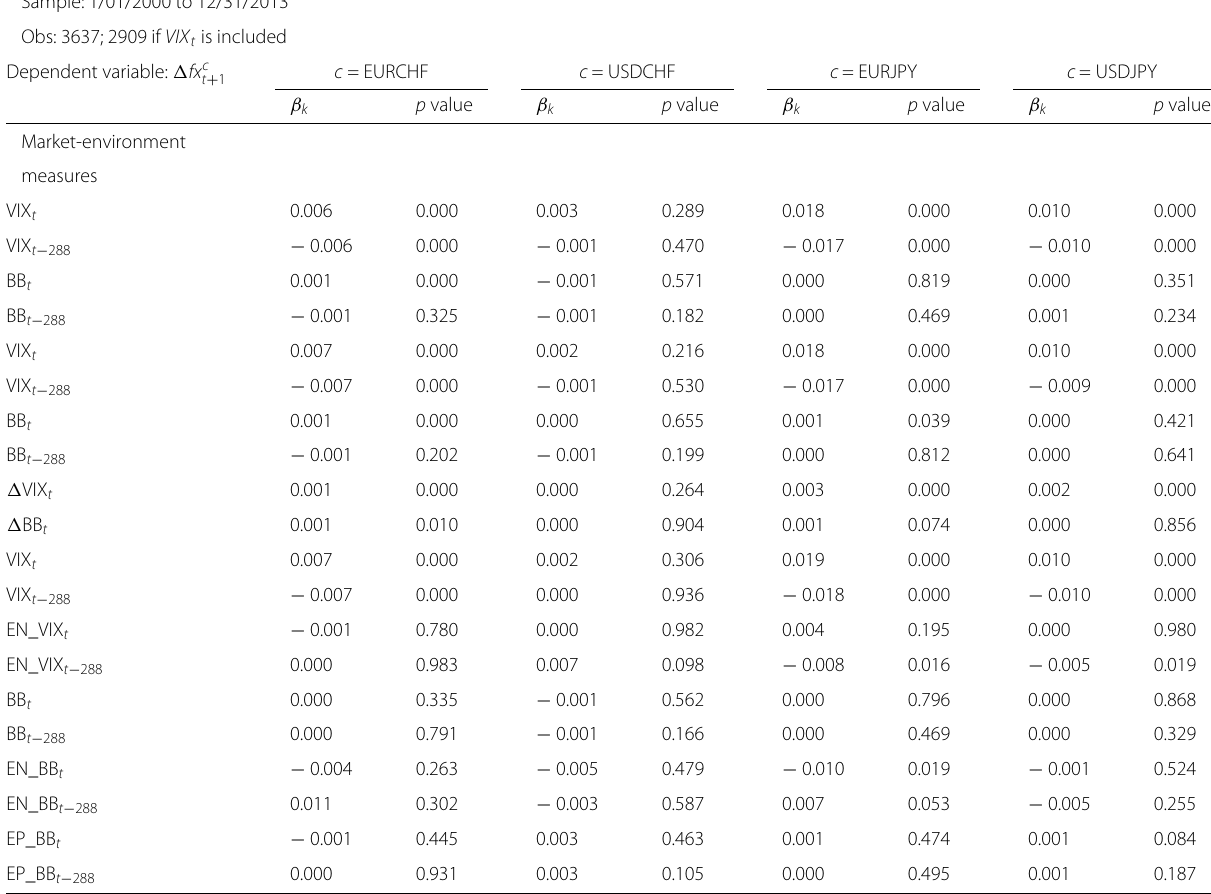
Table A2 Role of the market environment, daily